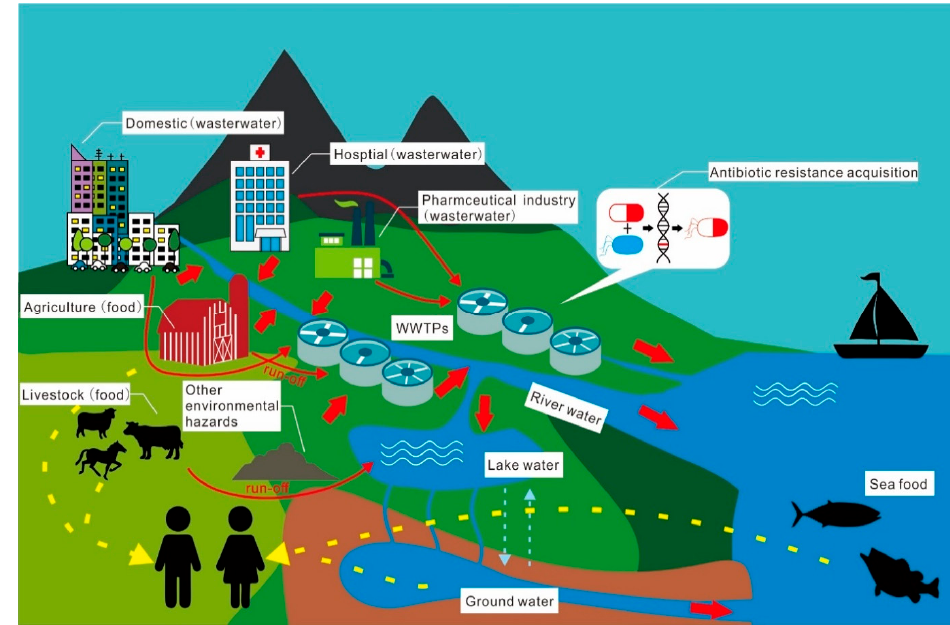
Figure 2. Migration, transformation, and the fate of antibiotics and their resistance in the given environment.